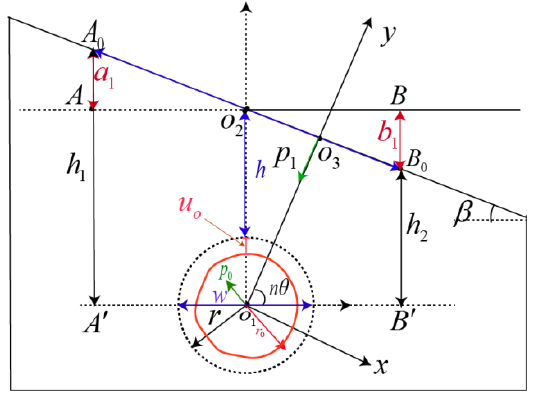
Figure 1. Geometrical representation of a shallow tunnel model beneath an inclined plane.